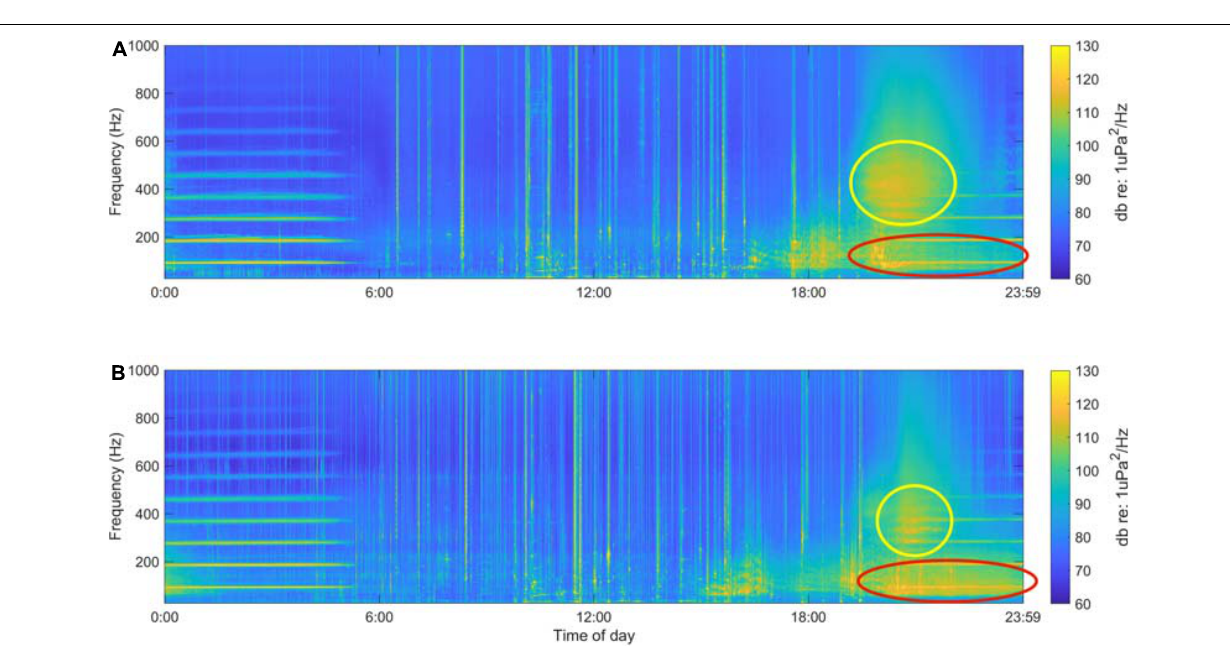
Frontiers in Marine Science |